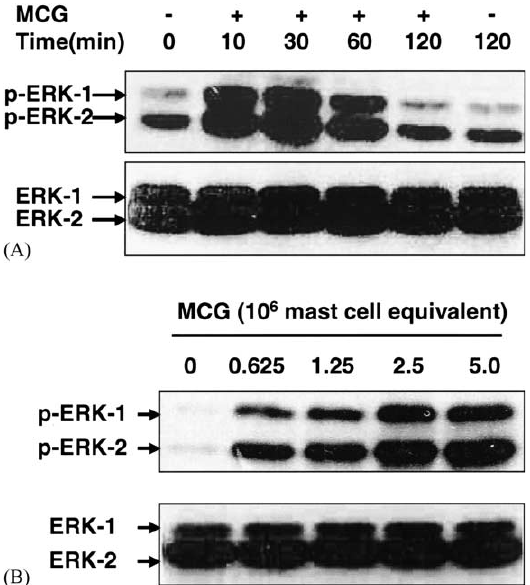
FIG. 4. The kinetics of MCG-mediated ERK1/2 activation in HUVECs. Confluent HUVECs (5 (cid:5) / 10 6 ) were treated with MCG (2.5 (cid:5) / 10 6 mast cell equivalents) for the time intervals indicated (A) or treated with the indicated doses of MCG for 30 min (B). After treatments, cell lysates were prepared and subjected to SDS-polyacrylamide gel electrophoresis followed by immunoblotting with phospho-specific ERK1/2 monoclonal antibody. Protein loads were monitored by western blot using ERK1/2 antibodies. Similar results were obtained in three experiments.